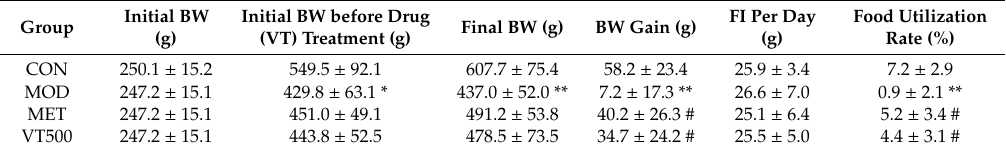
Table 1. E ff ect of VT on body weight (BW), food intake (FI), and food utilization rate in rats with T2D.